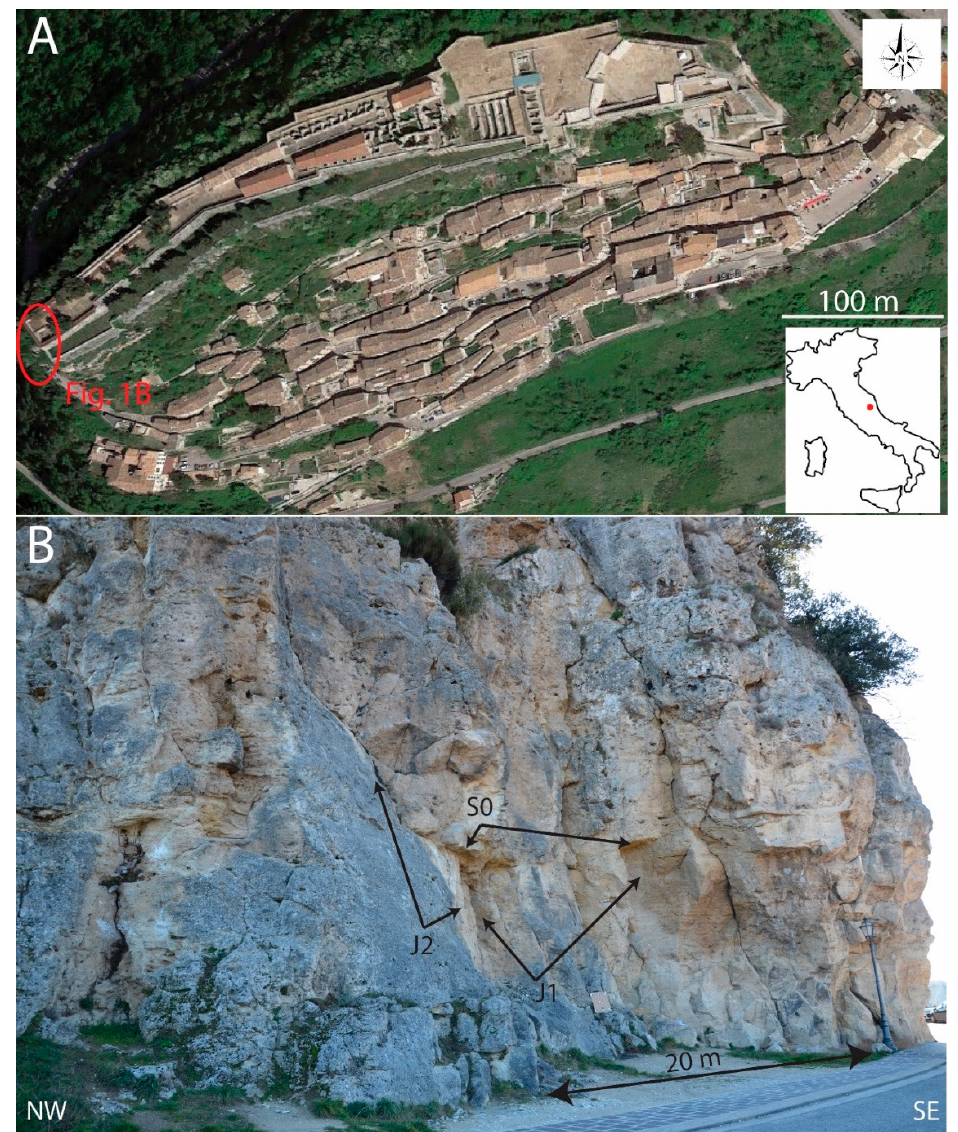
Figure 1. ( A ) Town of Civitella del Tronto, Italy. ( B ) Travertine rock slope outcropping to the west side of the town of Civitella del Tronto. The slope is characterized by two systematic joint sets, J1 and J2, and sub-horizontal bedding planes.